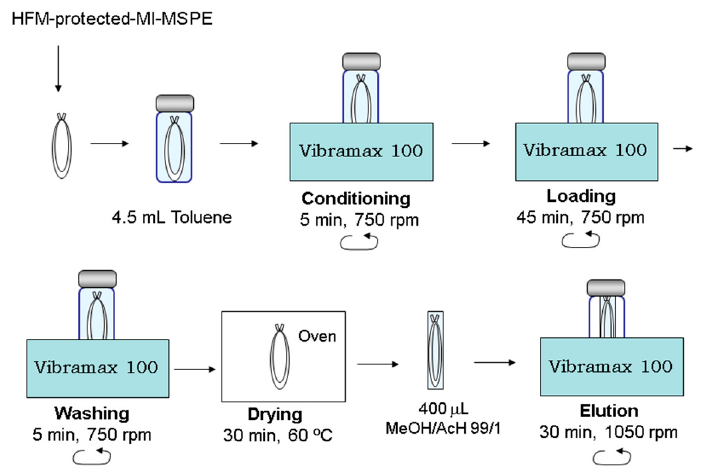
Figure 1. Scheme of the hollow-fibre membrane-protected molecularly imprinted microsolid-phase extraction procedure.